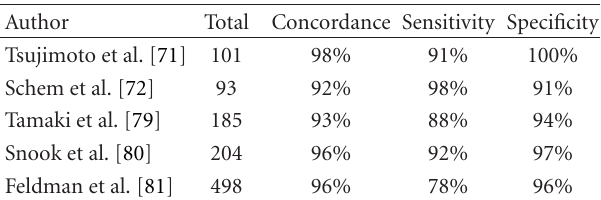
Table 5: Validation studies comparing OSNA with